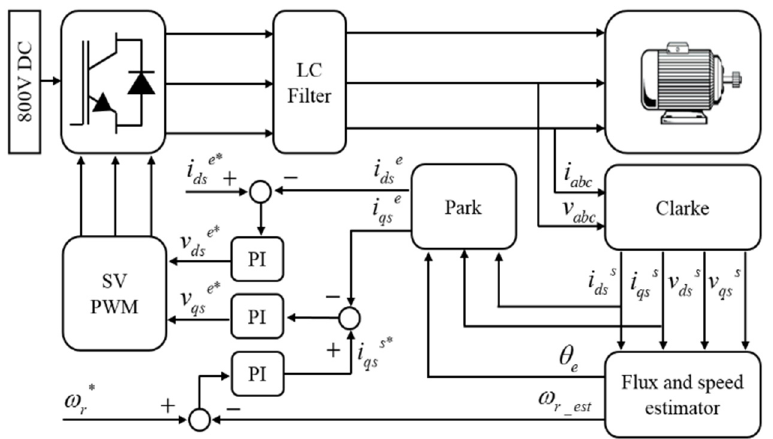
Figure 3. Indirect field-oriented control of IM.